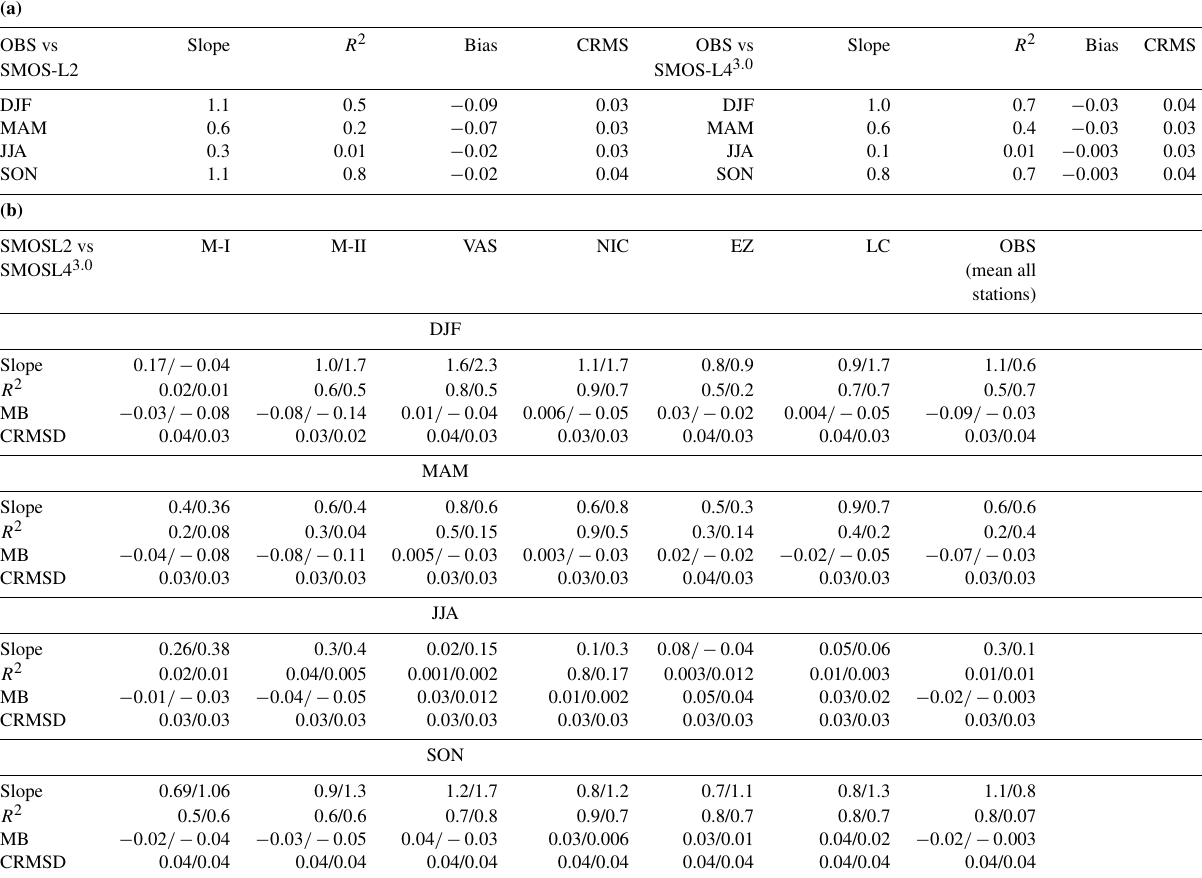
Table 3. Statistics of the comparisons between SMOS-L2 and SMOS-L4 3 . 0 soil moisture and ground-based measurements in the VAS network (the area covering the ground-based network has been called OBS; Fig. 1). SMOS descending orbits are selected for the comparison. Characteristics of the individual stations are given in Table 1. The acronyms for the names of the stations are as follows. M-I: Melbex-I, M-II: Melbex-II, VAS: VAS, NIC: Nicolas, EZ: Ezpeleta, LC: La Cubera. The period December 2011 to December 2012 is evaluated. The seasonal analysis follows the hydrological cycle. OBS stands for the average of (i) SMOS-L2 and/or SMOS-L4 3 . 0 soil moisture values within the 10x10km 2 where the ground-based network is placed, and (ii) in the case of the in situ observations, it refers to the mean of all stations. (a) shows a seasonal comparison between the mean of all in situ stations and the corresponding mean of SMOS-L2 and/or SMOS-L4 3 . 0 soil moisture values within the 10km × 10km area. In (b) SMOS-L2 and SMOS-L4 3 . 0 soil moisture observations are compared to point-like ground measurements using the closest grid point. The column on the right shows the mean of all